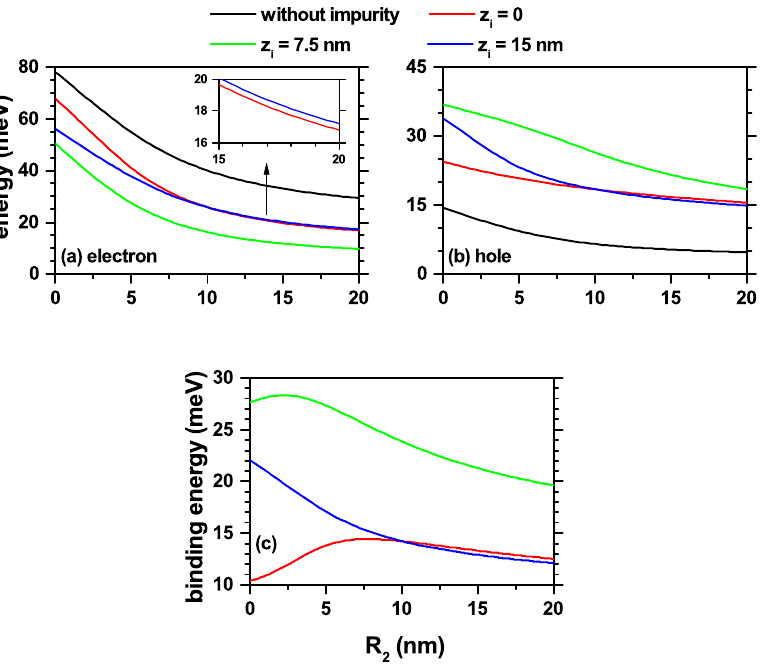
Figure 2. The ground state level for a confined electron/hole ( a )/( b ) in a truncated conical-shaped GaAs-Al 0.3 Ga 0.7 As quantum dot as a function of the R 2 -lower structure radius and the corresponding biding energy ( c ). Calculations are for R 1 = 10 nm, h = 15 nm, B = 0, with and without impurity effects according to the color code. Three impurity positions were considered: z i = 0, 7.5 nm, and 15 nm. The inset in Figure 2a shows, with better resolution, that the electron ground state energy for impurities at z i = 0 and z i = 15 nm should be different when R 2 > R 1 , as clearly seen in Figure 2b for the case of the